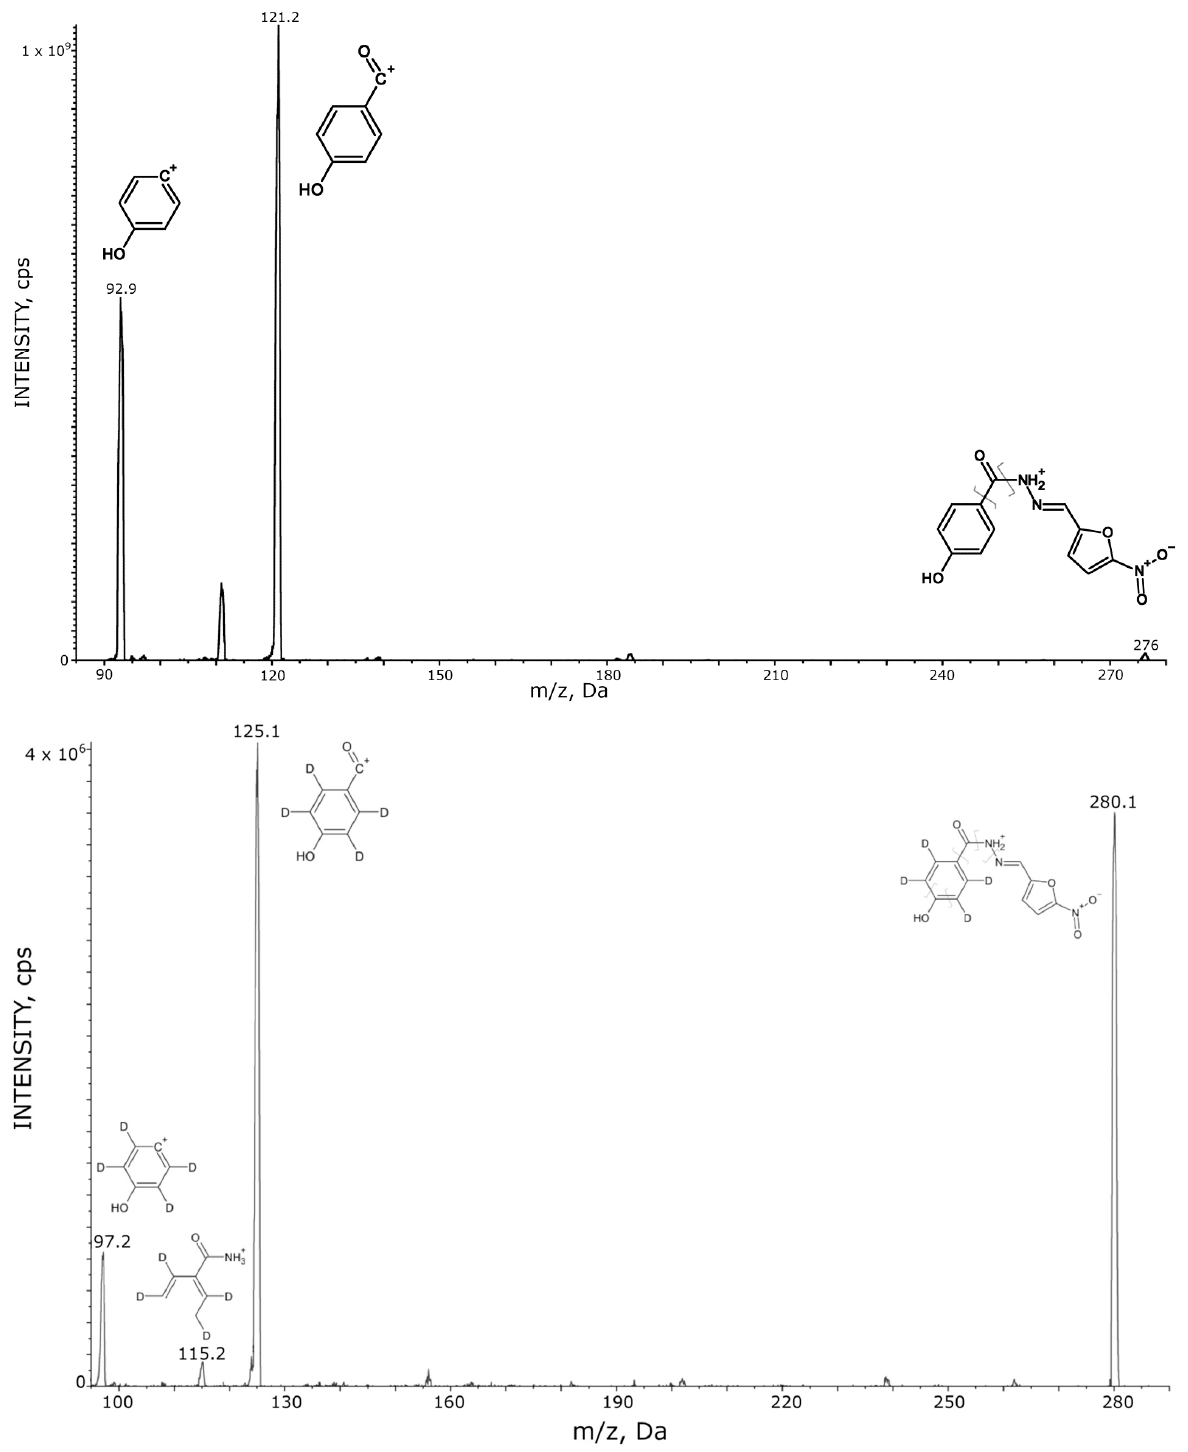
Figure 1. MS and MS/MS mass spectra for NAZ and IS ([ 2 H 4 ] nifuroxazide).